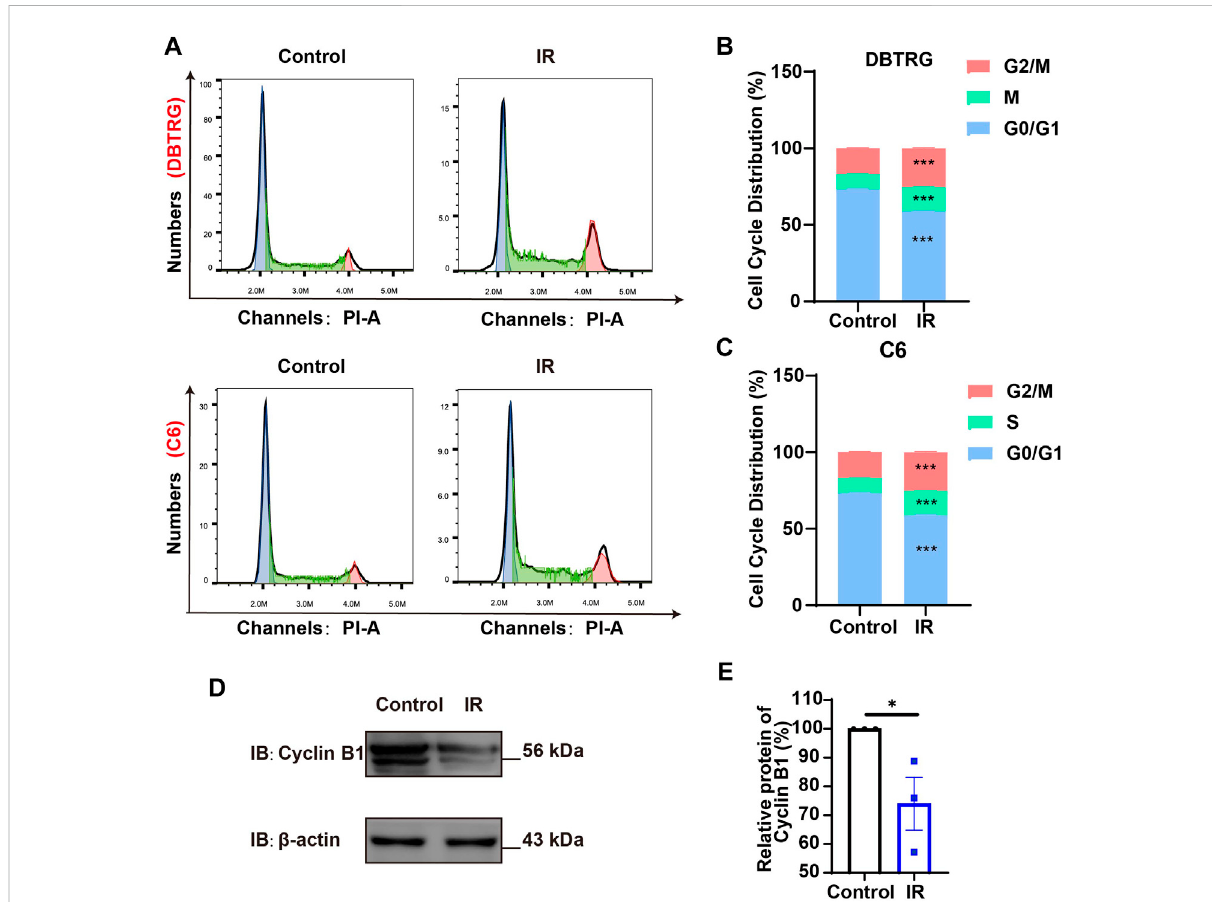
FIGURE 2 Irigenin promotedcell cyclearrest at G2/M ofGBM cells. (A) Flow cytometry assay with PIstaining showed thepercentageof eachcell phase in DBTRG and C6 cells treated with 50 μ M IR for 24 h (B – C) Quanti fi cation of cell cycle percentage in DBTRG cells (B) and C6 cells (C) as shown in (A) ( n = 3, per group). (D) Western blot detected the expression of Cyclin B1 in DBTRG cells treated with 50 μ M IR. (E) Quanti fi cation of the relative CyclinB1 level as shown in (D) ( n = 3, per group, normalized to control). Data were shown as mean ± SEM. *p < 0.05 , ***p < 0.001 , compared with control